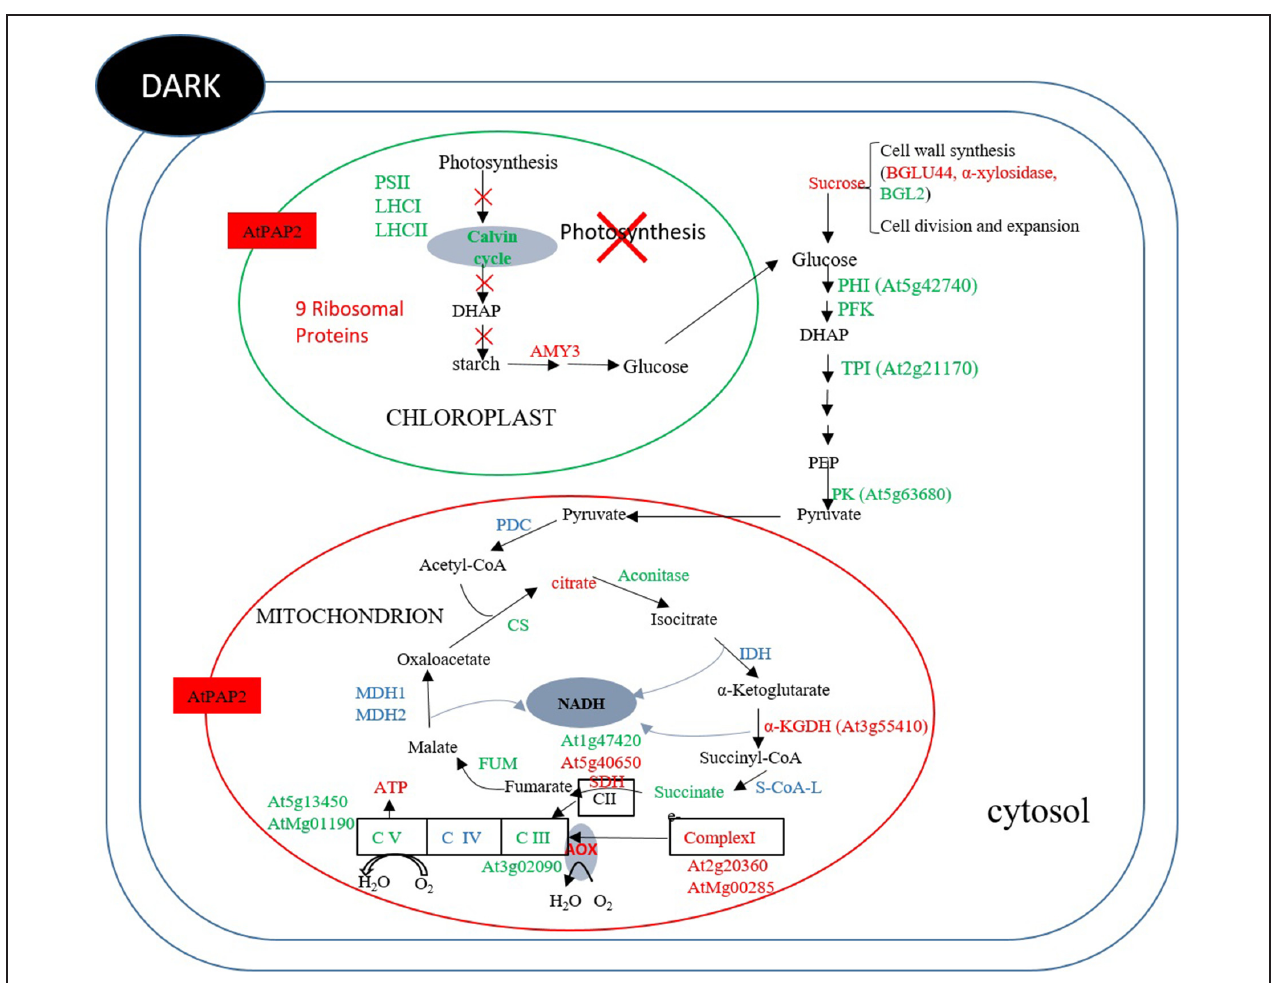
FIGURE 7 | Summary of protein and metabolites data at t = 0 h. Up-regulated proteins and metabolites in the OE line (vs WT) are indicated in red and down-regulated proteins and metabolites are indicated in green color. Undetected proteins and metabolites are indicated in black color. Proteins and metabolites without significant changes are shown in blue color. In dark, the abundances of some enzymes in the Calvin–Benson cycle, starch synthesis and glycolysis were lower in the OE line, whereas the abundance of alpha-amylase for starch breakdown was higher in the OE line. Regarding TCA enzymes and respiratory complexes of mitochondria, the protein abundances of some enzymes and subunits were significantly different between the OE and WT lines, reflecting the complexity of mitochondrial physiology.